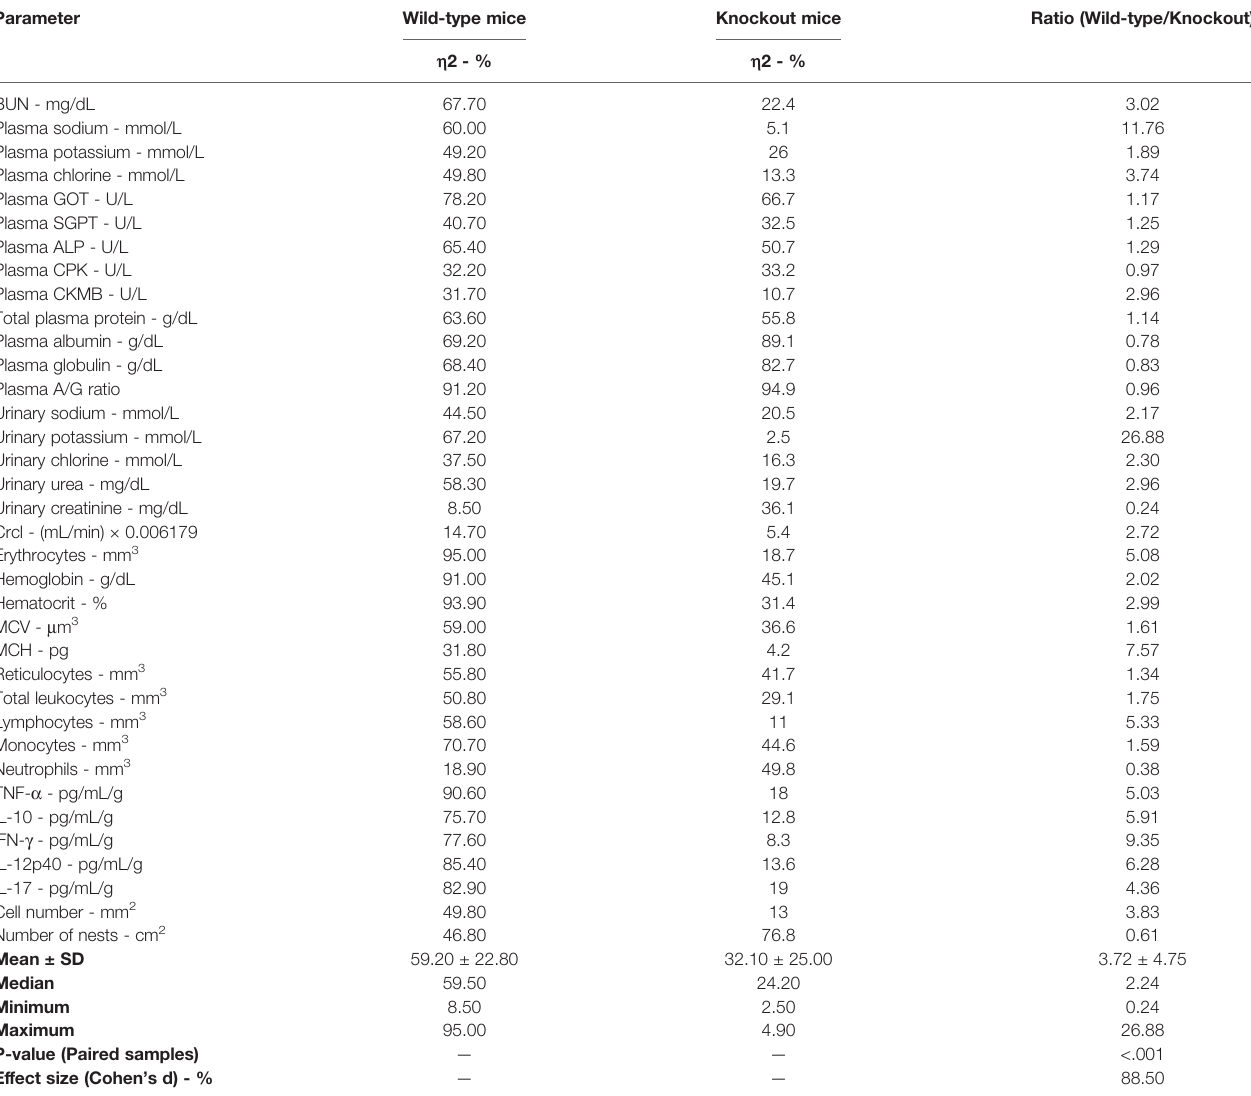
TABLE 4 | Determination of differences in the effects of Trypanosoma cruzi inoculum concentrations (low, medium, and high) of “ Y ” strain on clinical laboratory markers, in fl ammatory, and histopathological parameters between wild-type and knockout (iNOS -/- ) mice with acute infection. Parameter Wild-type